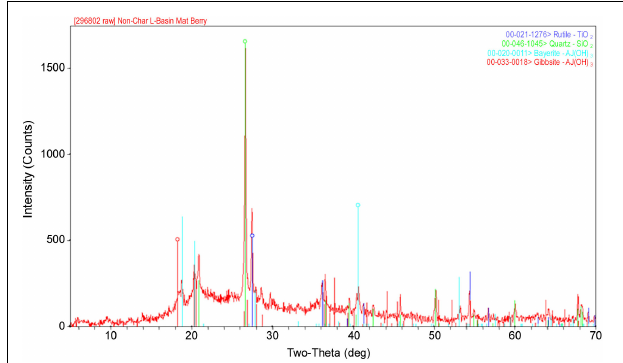
FIGURE 3 | A representative XRD spectra of a composite sample of the precipitate collected from multiple locations throughout the spent nuclear fuel storage basin.